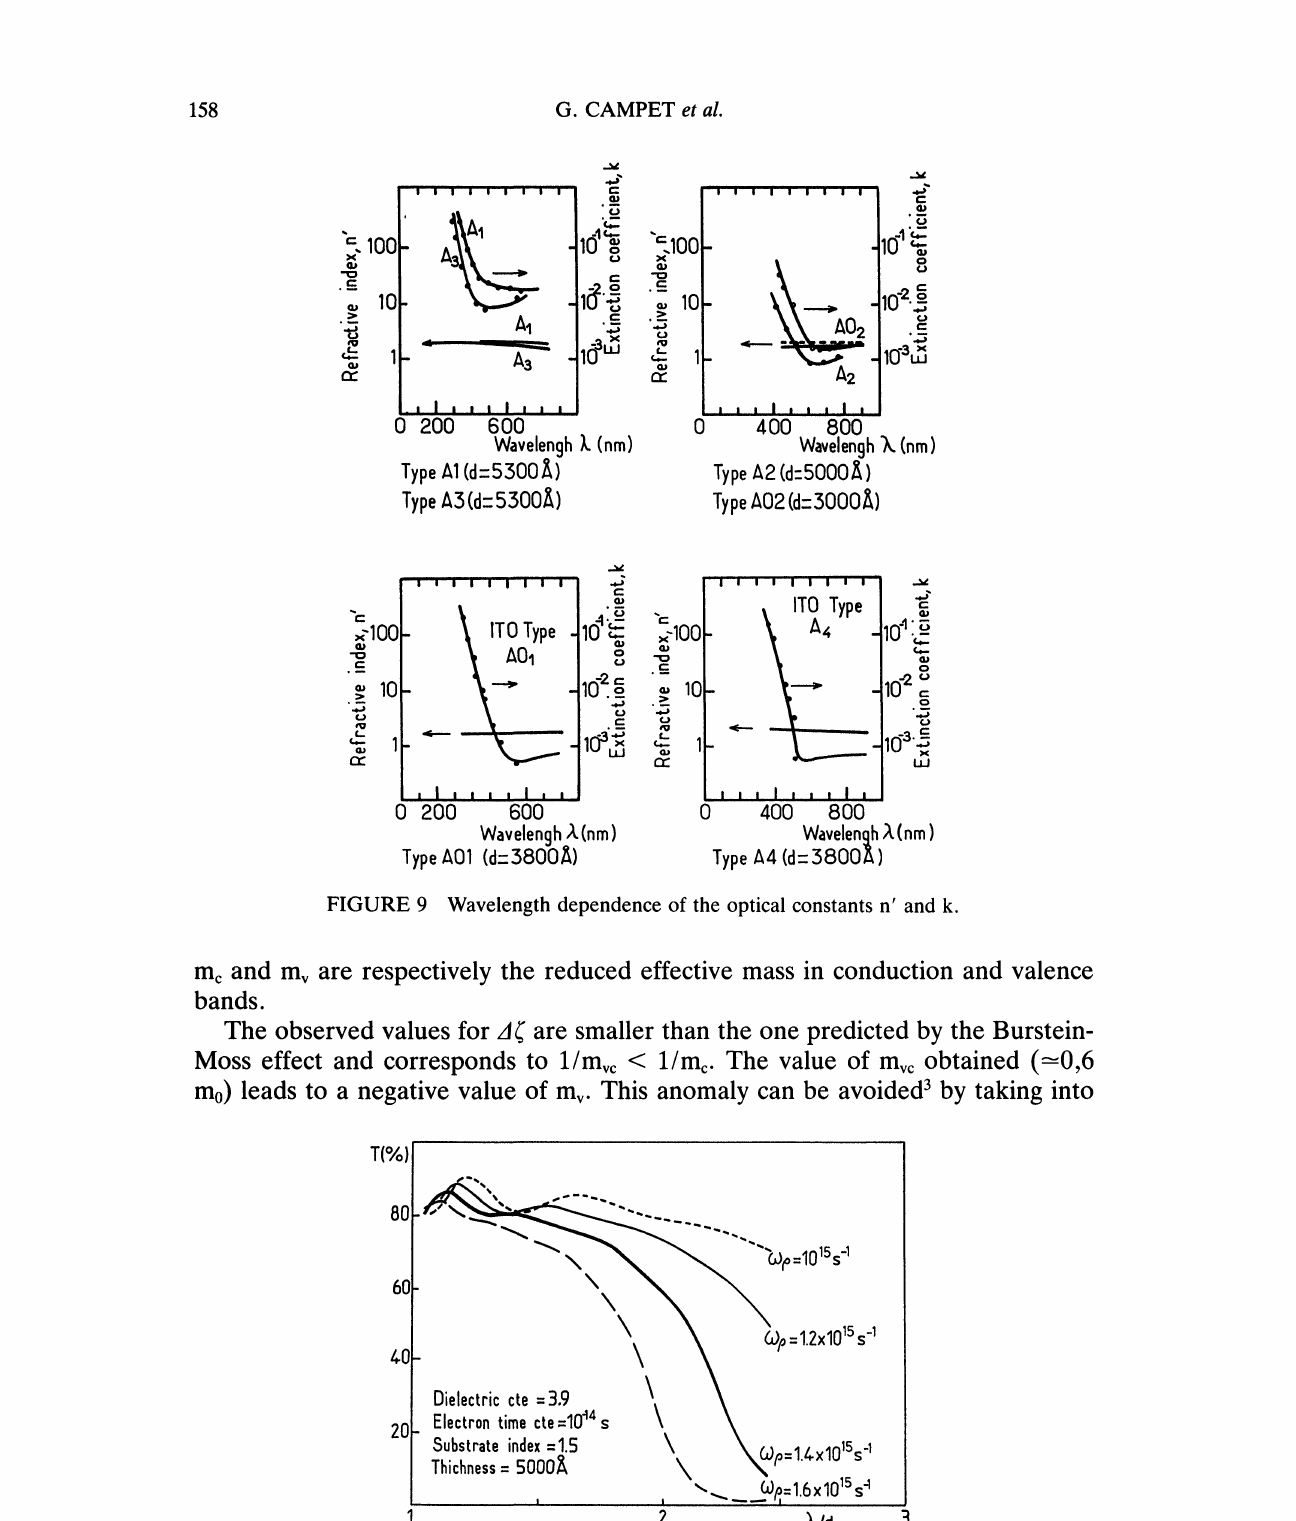
FIGURE 10 Influence of plasma oscillations on the optical properties of ITO films (theoretical